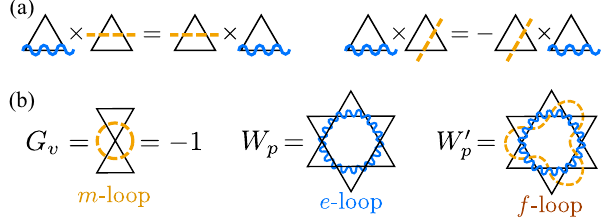
FIG. 3. Topological string operators and stabilizers for dimer liquids. We define diagonal Z α [orange; Eq. (3)] and off-diagonal X α [blue; Eq. (7)] operators in the spin- 3 = 2 Hilbert space, which, respectively, create pairs of m and e anyons in our emergent dimer model. (a) These string operators anticommute when they intersect, encoding the mutual semionic statistics of e and m anyons. (b) Closed loops of these operators define commuting stabilizers. We add the diagonal loop (which is a two-body operator in the spin- 3 = 2 space) as an energetic constraint in the − 1 enforces the dimer model (15); at low energies, G v ¼ constraint. Single-site e -anyon ( f -anyon) fluctuations perturba- tively generate the W ( W 0 ) stabilizers, which can be interpreted p p as worldlines of these anyons around a plaquette. The Hamil- tonian for the fixed-point dimer liquid on the kagom´e lattice is P P − G W simply H ¼ v p v p